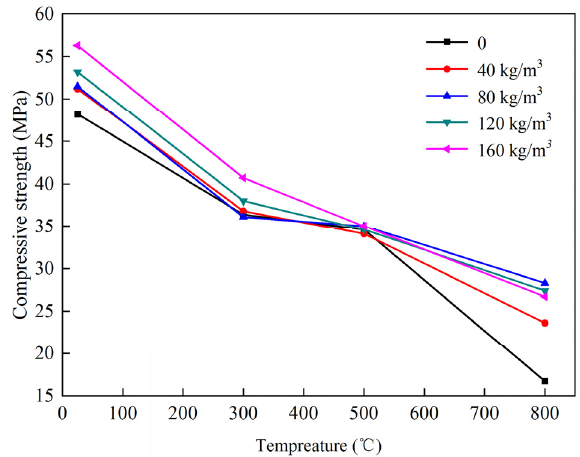
Figure 2. Residual compressive strength of SFRC as a function of temperature [39].